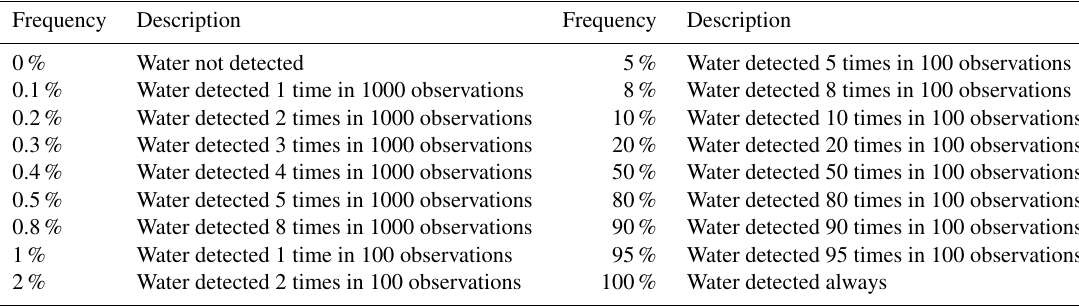
Table 1. The categories of recurrence frequency for which calculations were performed.